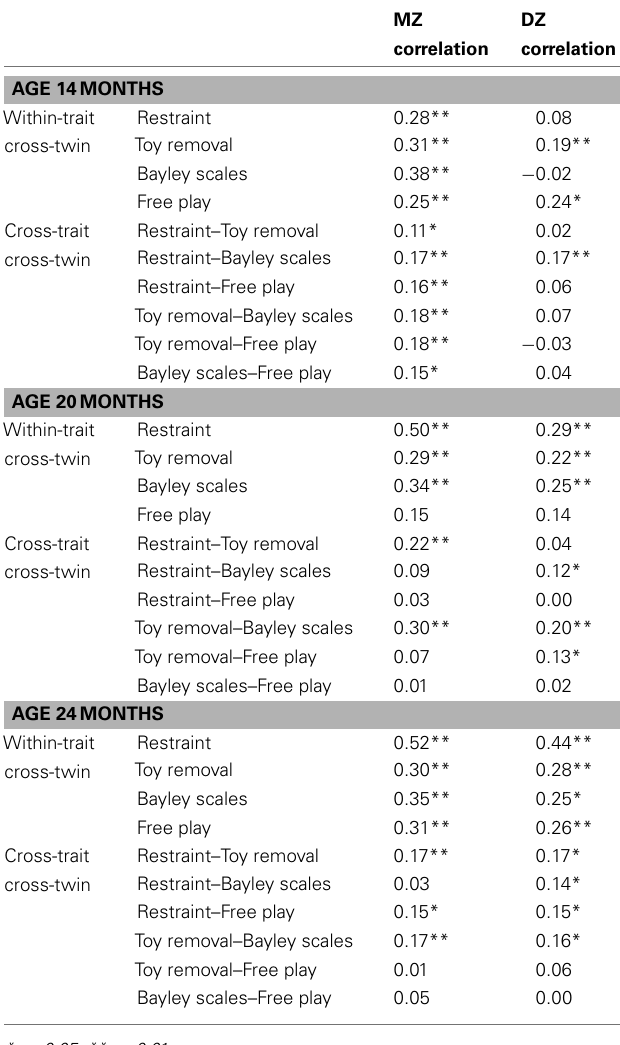
Table 4 |Within-trait cross-twin and cross-trait cross-twin correlations.